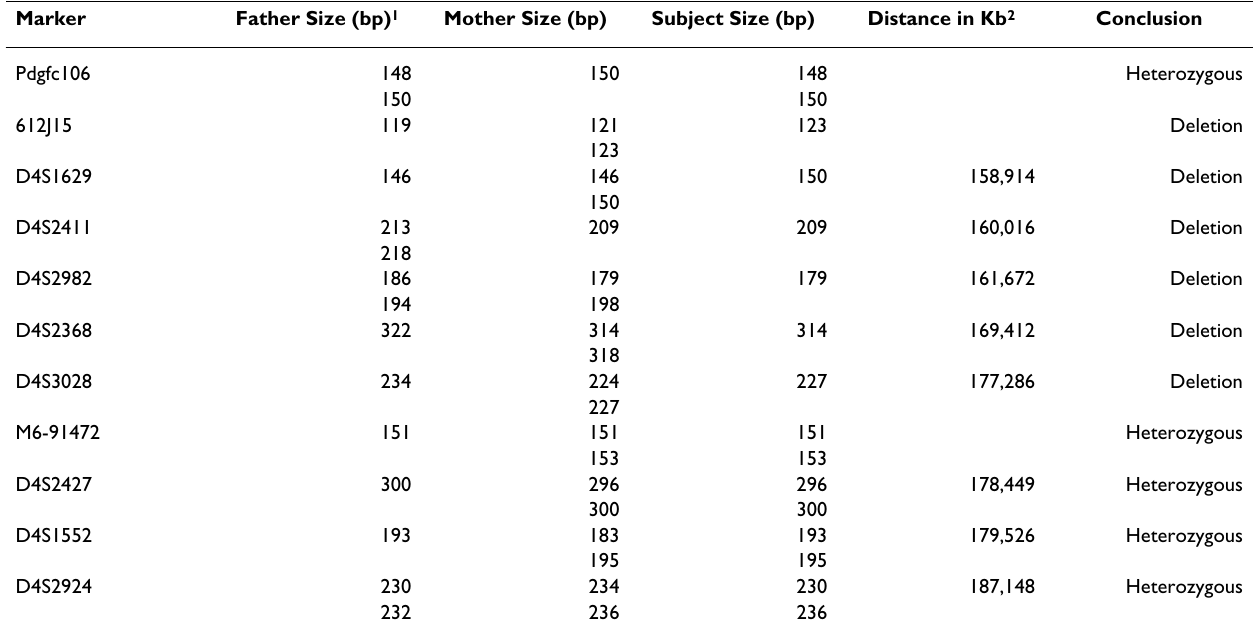
Table 3: Genotyping of markers on chromosome